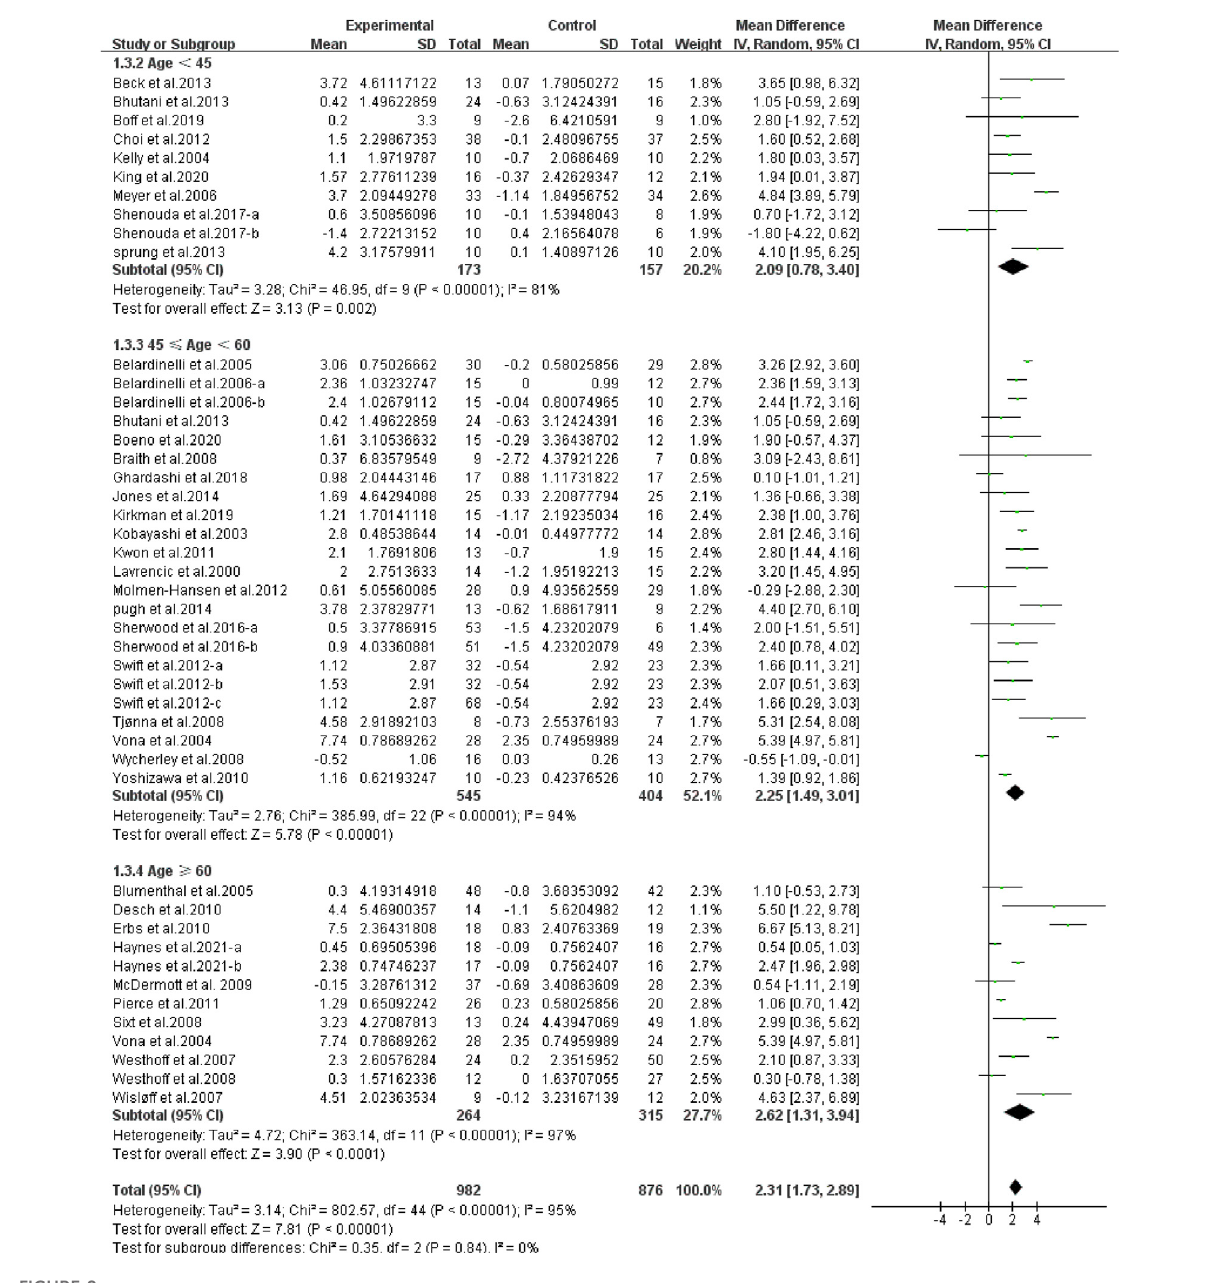
FIGURE 8 Meta-analysis results of the effect of continuous aerobic exercise on FMD in young, middle-aged, or elderly people. The pooled estimates were obtained from random effects analysis. Diamonds indicated the size of the effect of each study summarized as WMD. The size of the shaded square was proportional to the percentage weight of each study. Horizontal lines represented the 95% CI and the vertical dashed line represented the overall